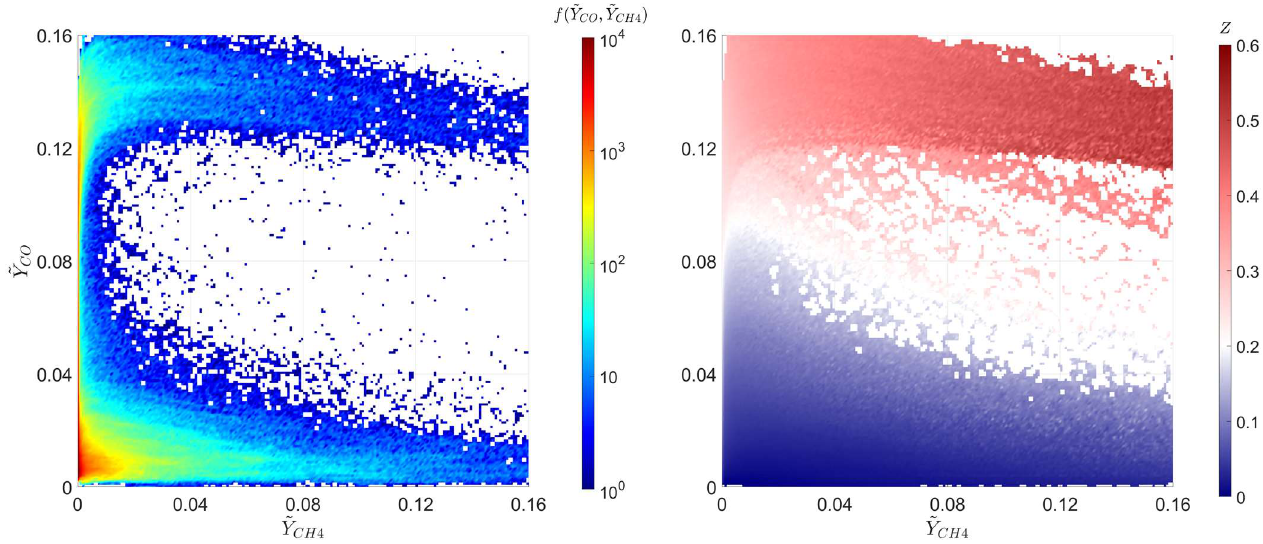
Figure 5. Main combustion regimes in the studied cell: joint probability density function of the mass fractions of methane and carbon monoxide ( a ), Favre-average mixture fraction as a function of the mass fractions of methane and carbon monoxide ( b ).